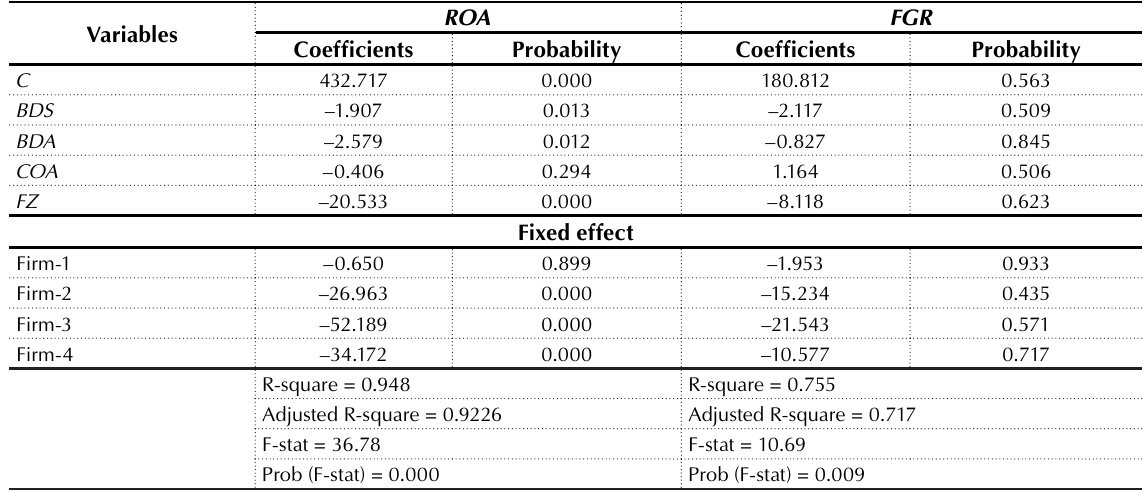
Table 4. Fixed effect estimations